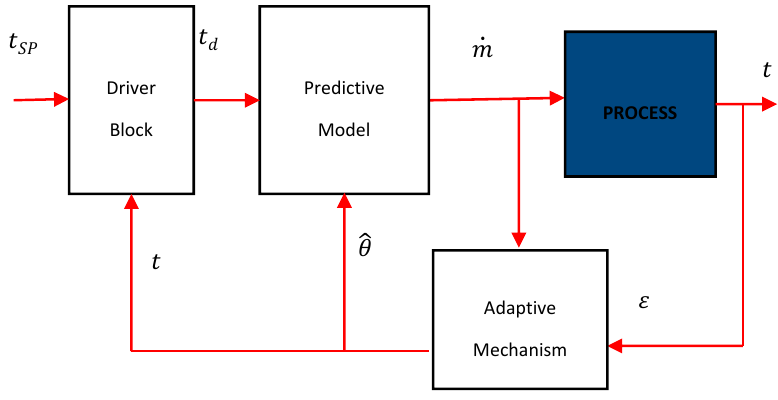
Figure 5. Adaptive–predictive control scheme block diagram.